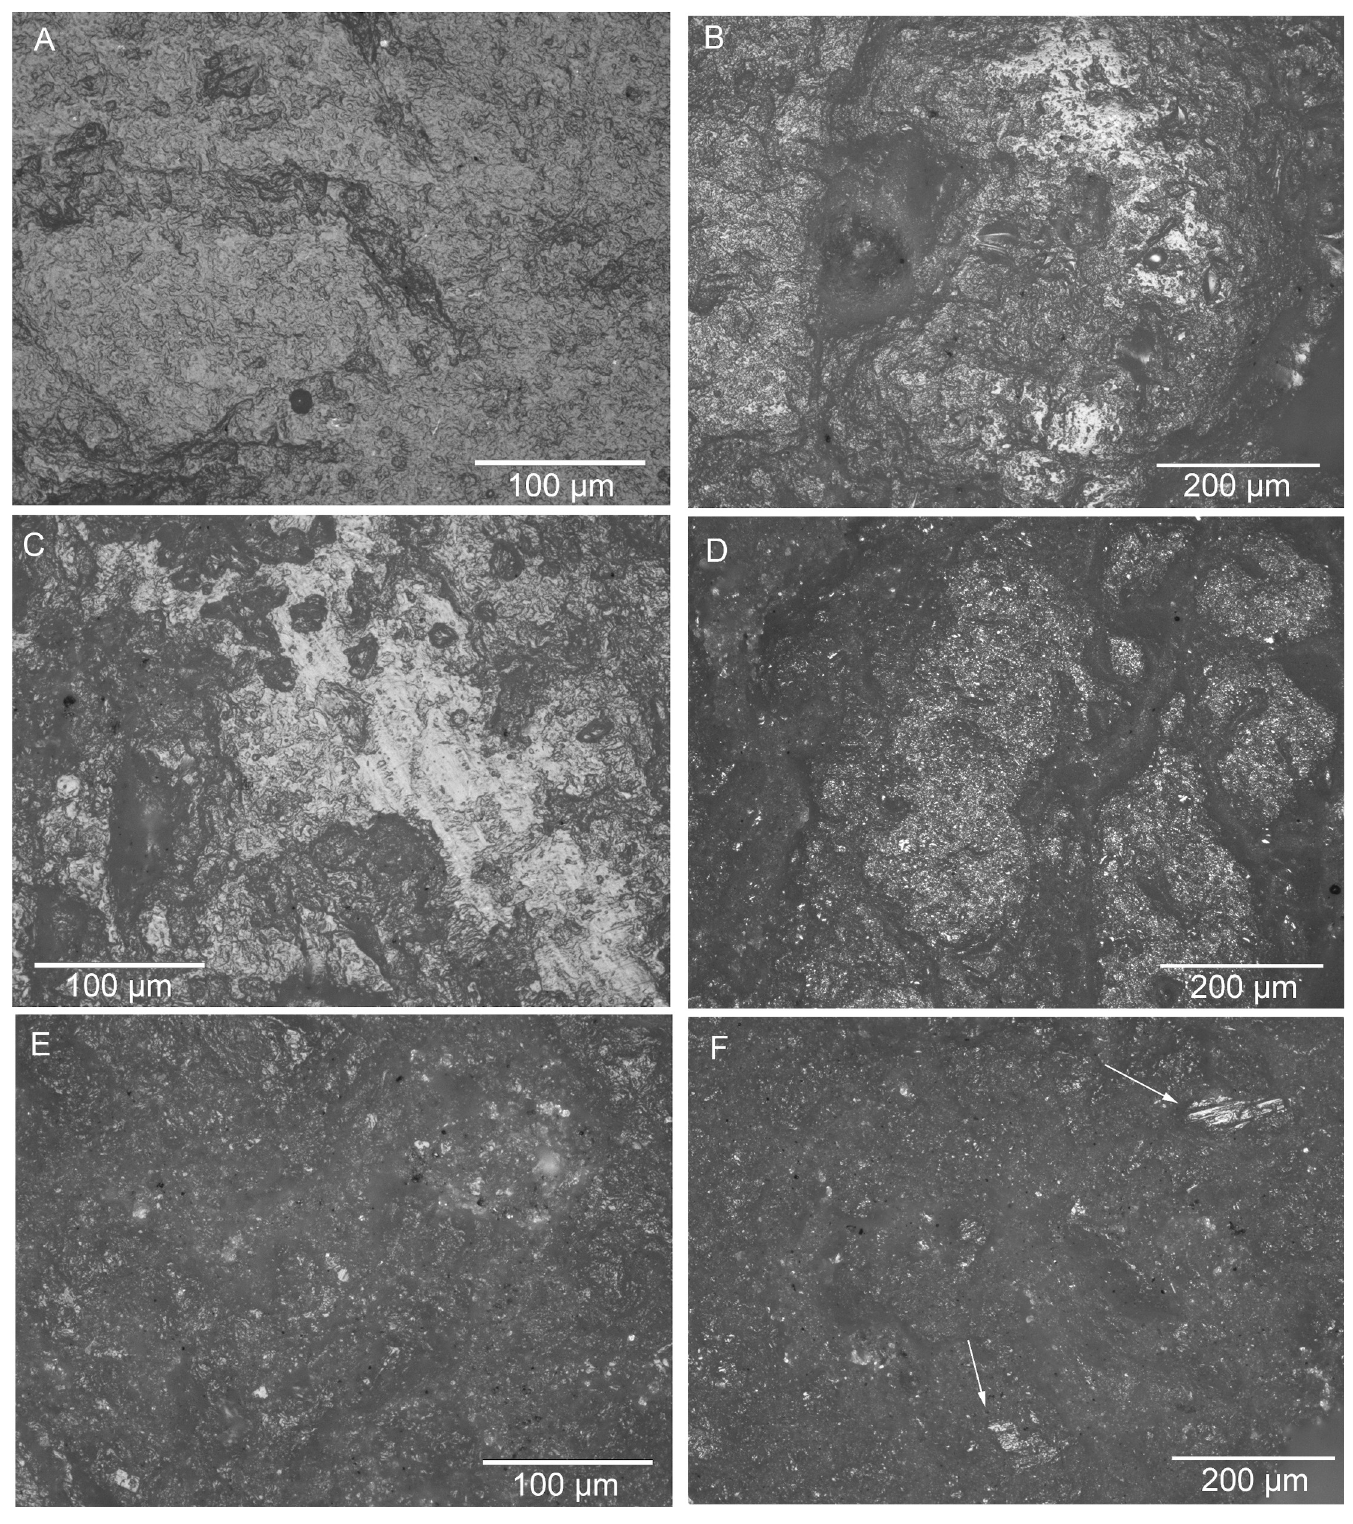
Fig 11. Microwear traces on grinding tools. A) 11648.x22 clay/plaster micropolish (200x); B) 11648.x22 woody plant micropolish (100x); C) 11648.x14 mineral micropolish (200x); D) 11648.x8 plant (cereal) micropolish forming distinct patches (100x); E) 21767.x2 plant micropolish (200x); F) 10292.x2 plant (legumes)